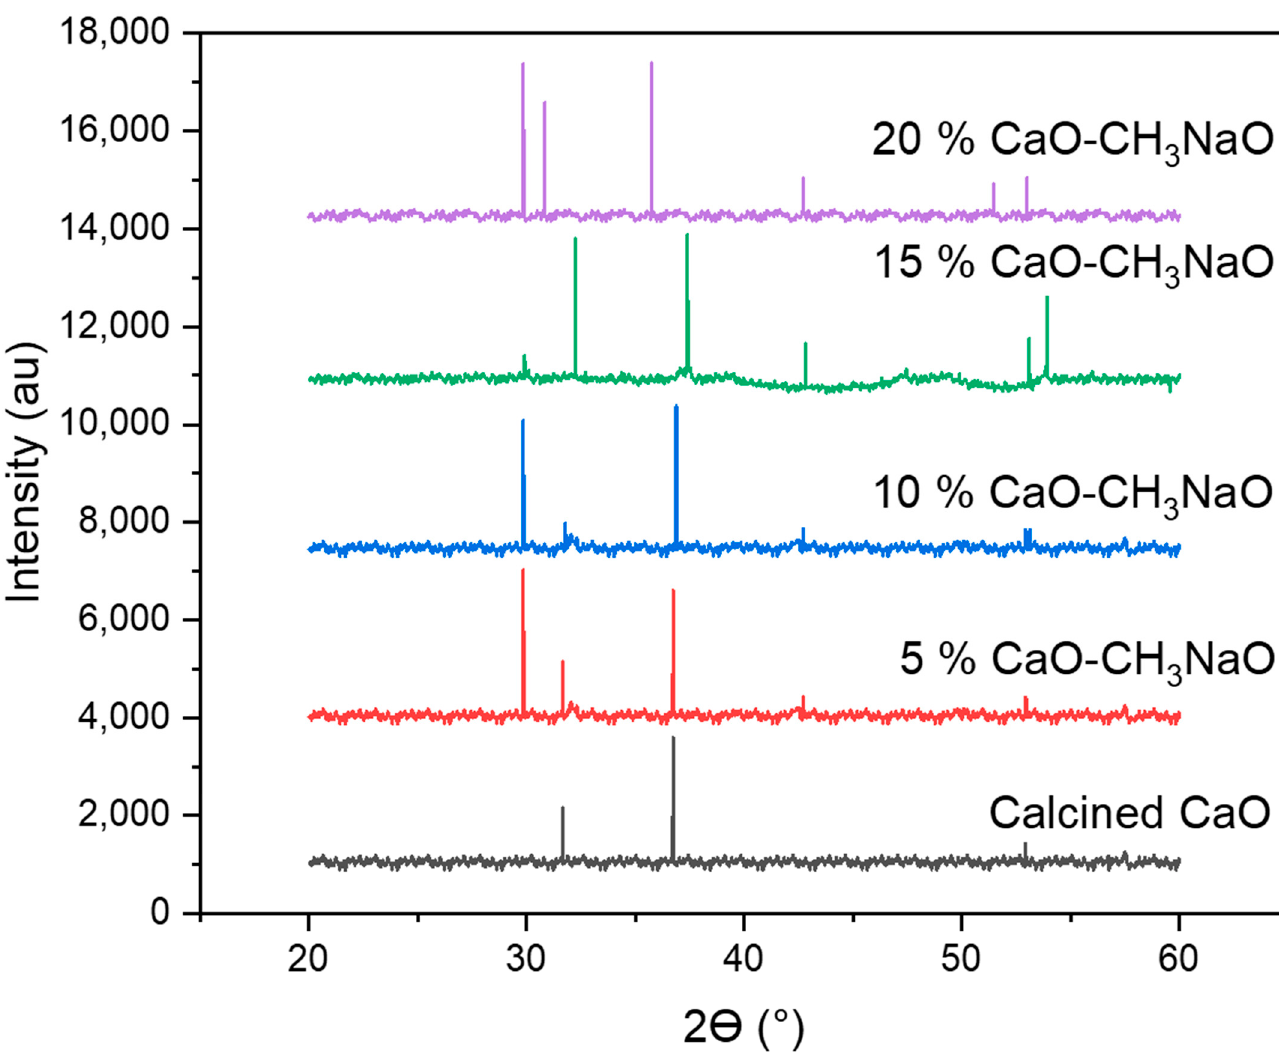
Figure 2. XRD studies of calcined CaO and CH 3 NaO-doped CaO catalyst with different doping ratios.